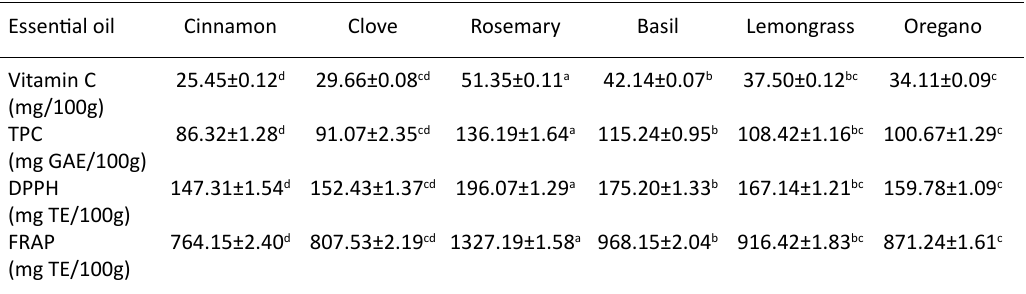
Table 4. Effect of herbal essential oil ahead-treatment prior to Microwave-air dehydration to phenolic content and antioxidant capacity in flower